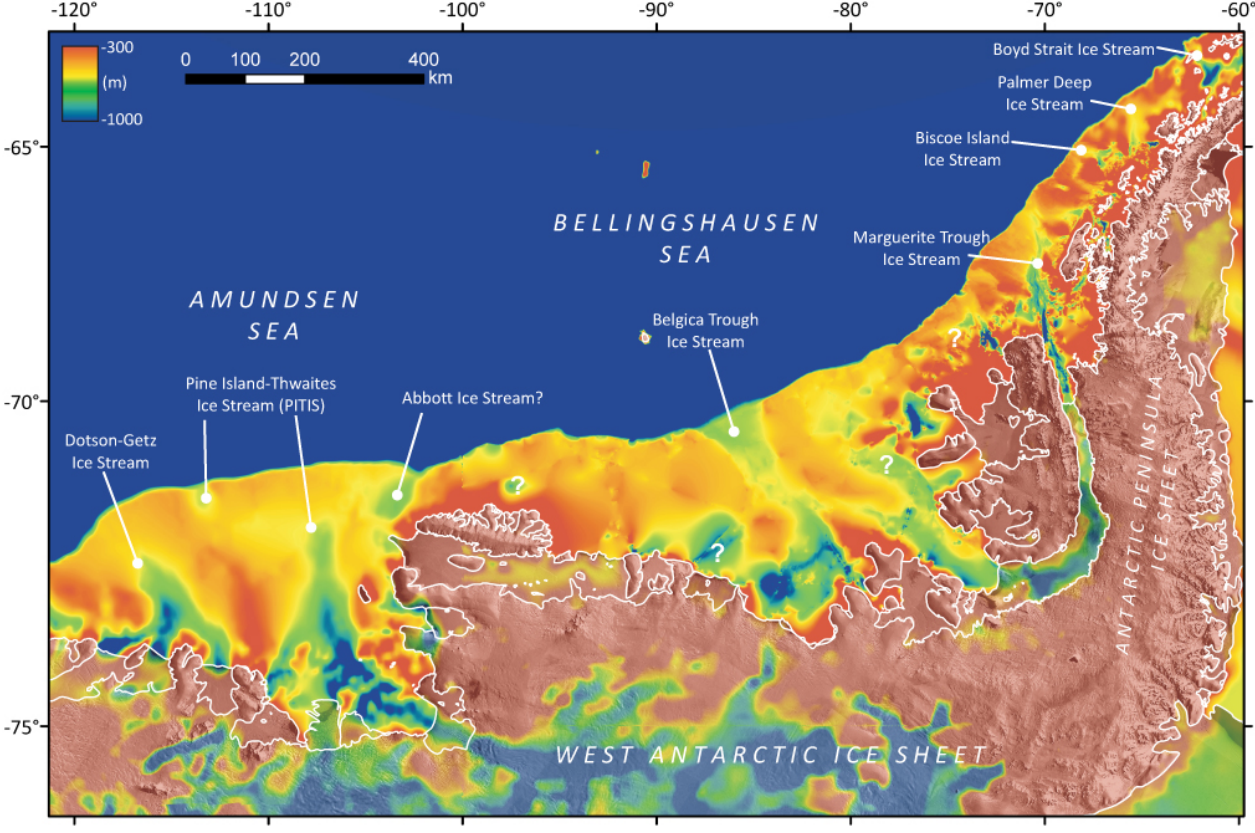
Fig. 5. Compilation of bathymetric charts for the West Antarctic Pacific margin (this study; Rebesco et al., 1998; Nitsche et al., 2007; Bolmer, 2008; Le Brocq et al., 2010), illustrating cross-shelf morphologies which were the principle drainage pathways for numerous palaeo- ice streams (labelled). Ice stream pathways are identified based on interpretations of Anderson et al. (2002), Heroy and Anderson (2005), Evans et al. (2006), ´O Cofaigh et al. (2005a, b), Domack et al. (2006), Larter et al. (2009) and Graham et al. (2010). 4 areas still requiring investigation are highlighted with a question mark. Mercator WGS84